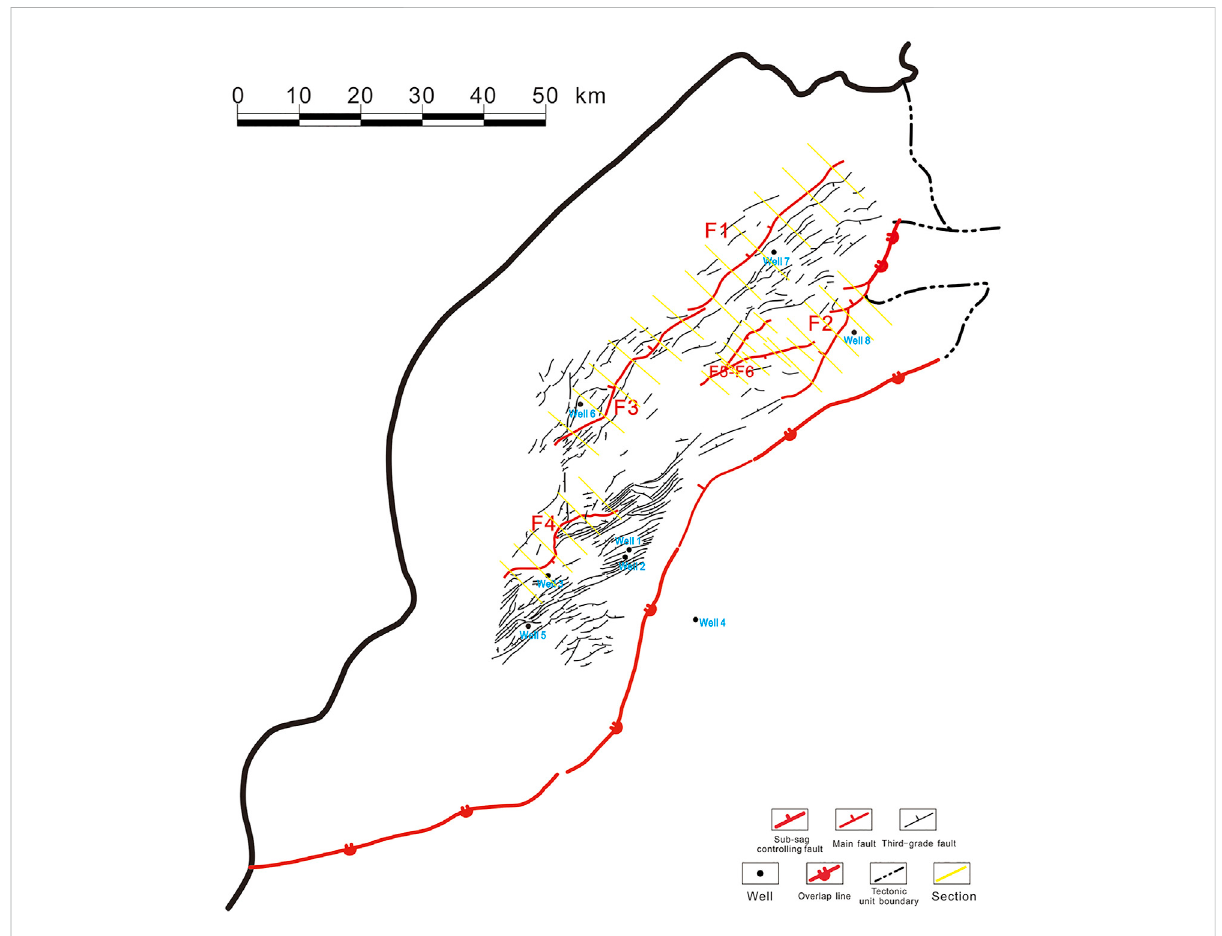
FIGURE 3 Fault system of the T90 re fl ector in the Lishui West